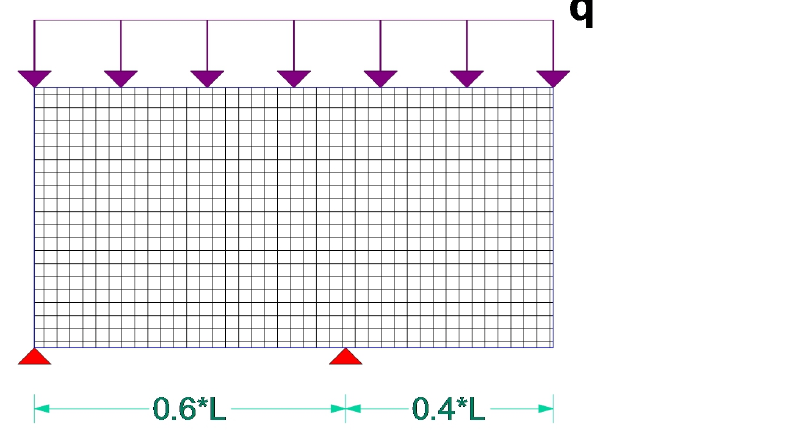
Figure 5. Definition of test example A.